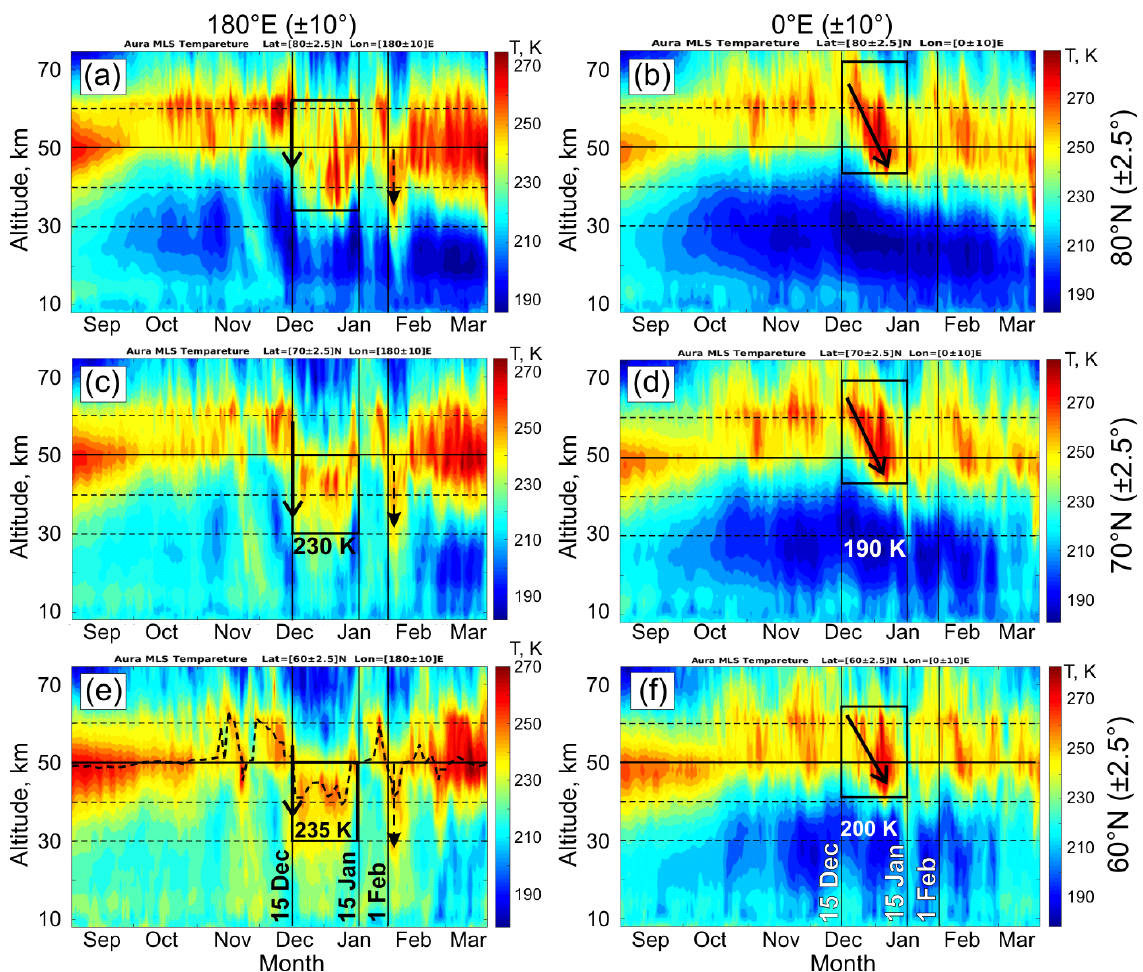
Figure 3. Vertical temperature profiles from Aura MLS in September 2019–March 2020 at longitudes ( a , c , e ) 180 ± 10 ° E and ( b , d , f ) 0 ± 10 ° E for latitudes ( e , f ) 60 ± 2.5 ° N, ( c , d ) 70 ± 2.5 ° N, and ( a , b ) 80 ± 2.5 ° N. The time interval of the descending stratopause, 15 December–15 January, is indicated by vertical lines, and the temperature maximum is outlined by a rectangle. Arrows show tendencies in the decent of the temperature maximum. The thick solid line highlights the typical stratopause altitude of 50 km, and thin horizontal dashed lines are shown at 30, 40, and 60 km altitude. The thick dashed line in ( e ) shows the time-altitude evolution of the temperature maximum at the stratopause.